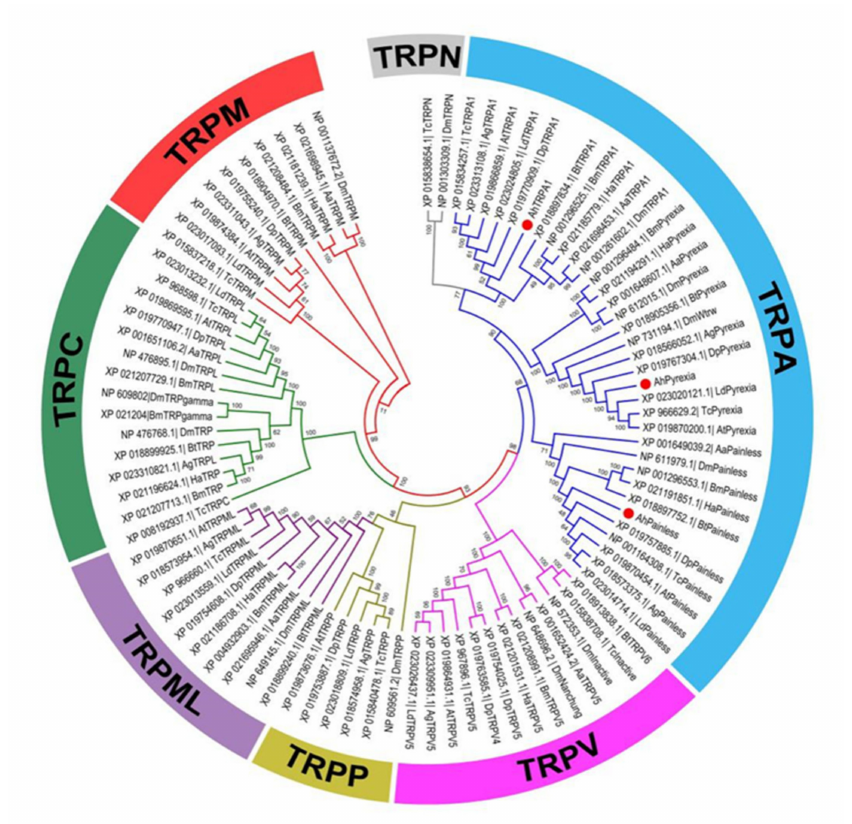
Figure 2. Phylogenetic analysis of transient receptor potentials (TRPs) in Agasicles hygrophila and other insects. Ninety TRP sequences from 11 species of four insect orders were used to construct this phylogenetic tree. The GenBank accession numbers of these sequences are listed in Table S2. The TRPA1, Painless, and Pyrexia of Agasicles hygrophila are represented by red dot “ •